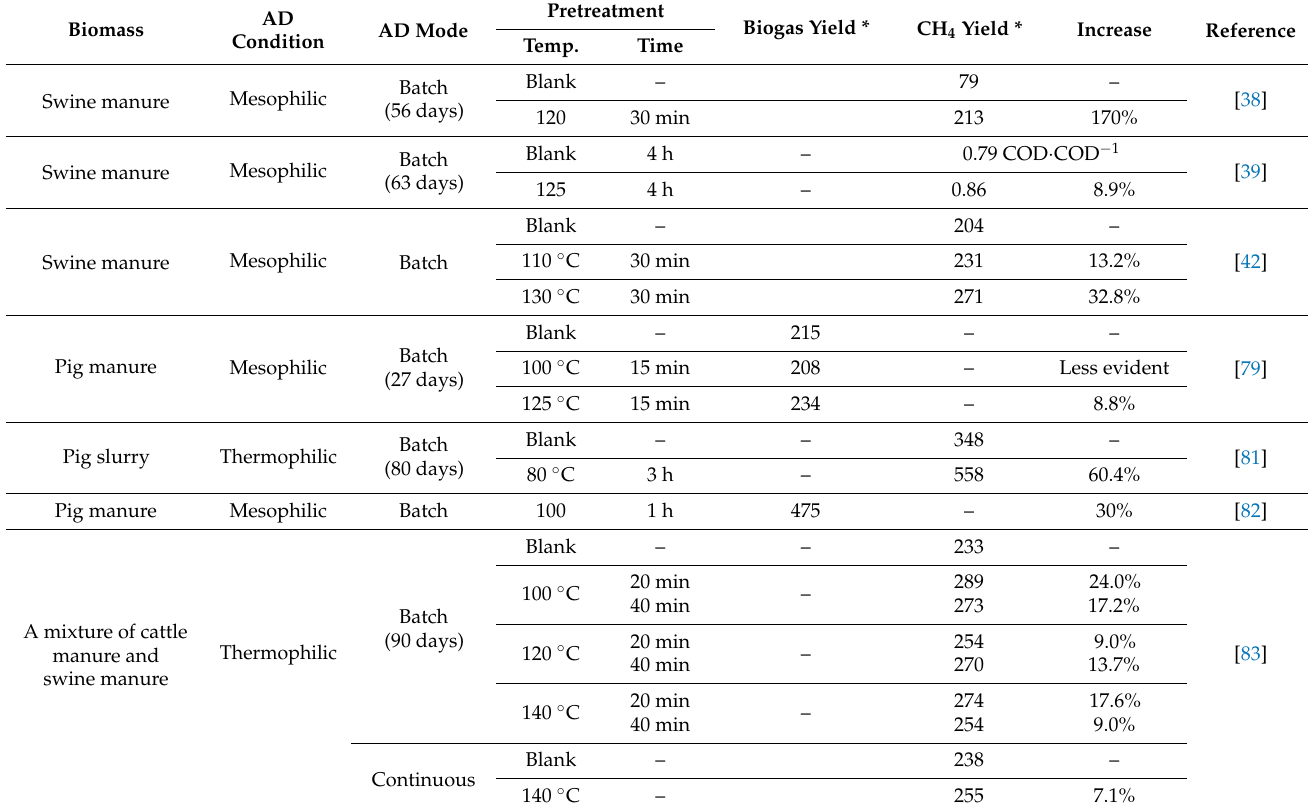
Table 2. Biogas production variation of pig manure after LTPT (Temp. ≤ 140 ◦